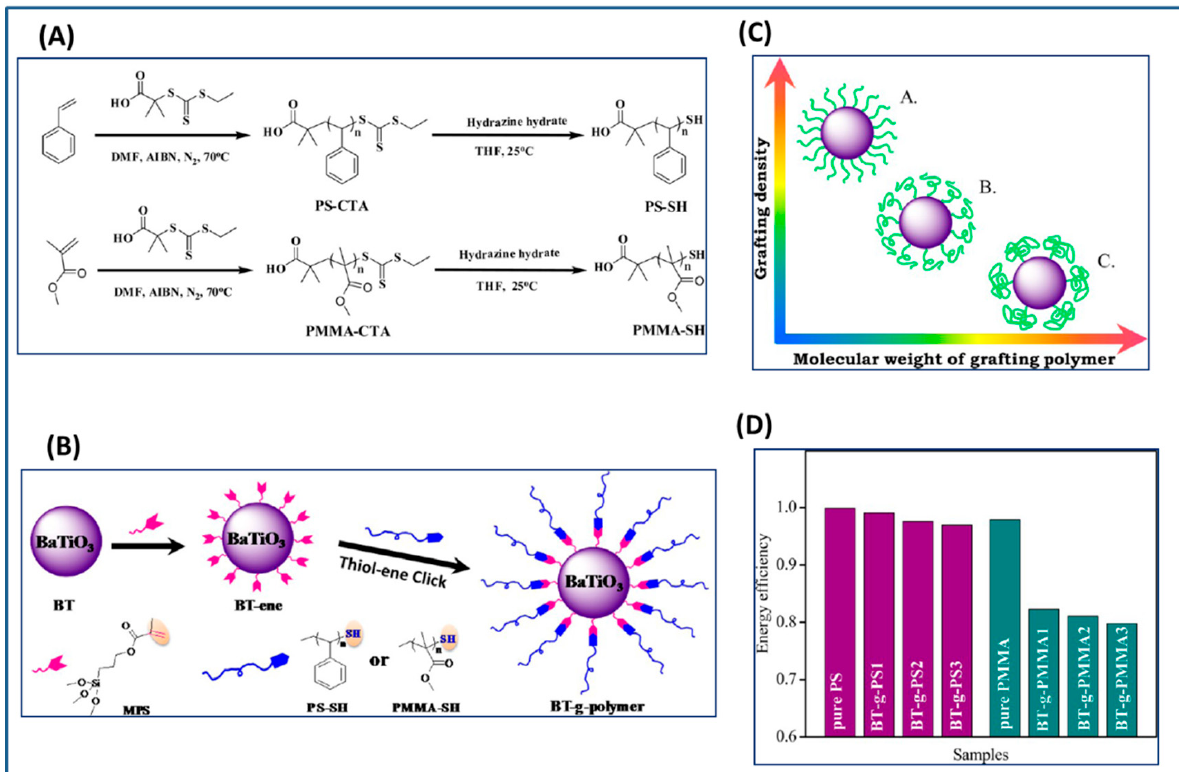
Figure 19. Schematic illustration for ( A ) synthesis of thiol-terminated PS and thiol-terminated PMMA via RAFT polymerization and ( B ) preparation of core-shell structured polymer@BaTiO 3 nanocomposites by thiol − ene click reaction. ( C ) The relationship between the molecular weight of grafting polymer and grafting density of the core-shell structured nanoparticles ( D ) Energy efficiency of the core-shell structured polymer@BT nanocomposites under the electric field of 10 kV/mm. Reproduced with permission from Ref.